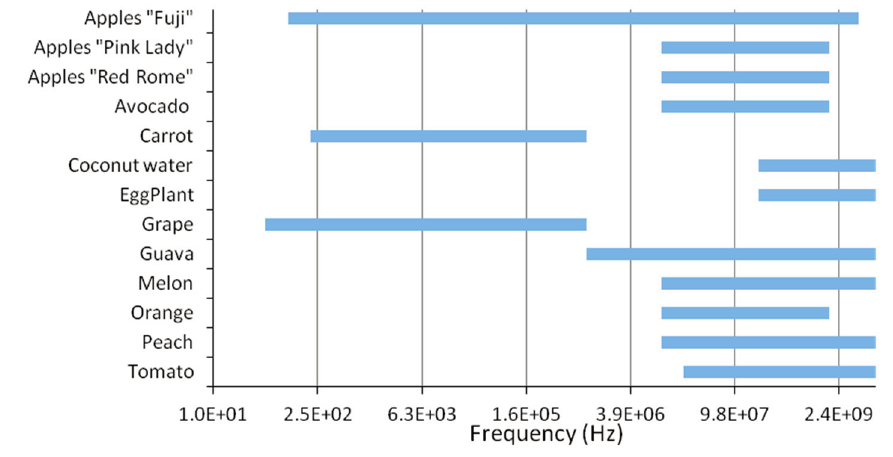
Figure 4. Frequency Ranges applied for fruit and vegetable